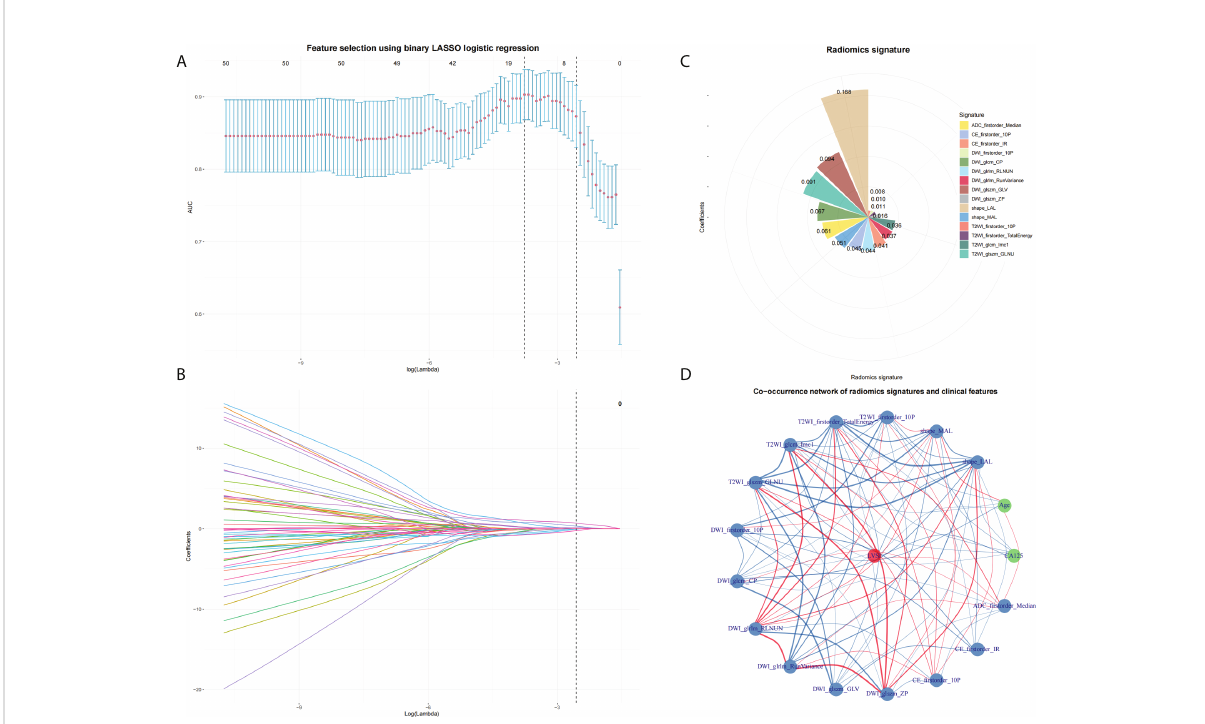
FIGURE 3 Feature selection by using LASSO. (A) The parameter lambda is chosen using 10-fold cross-validation via minimum criteria, which results in 10 features with non-zero coef fi cients. (B) LASSO coef fi cient pro fi les of the selected features. (C) Radiomics signature. (D) A co-occurrence network shows the correlations between radiomics signature and clinical